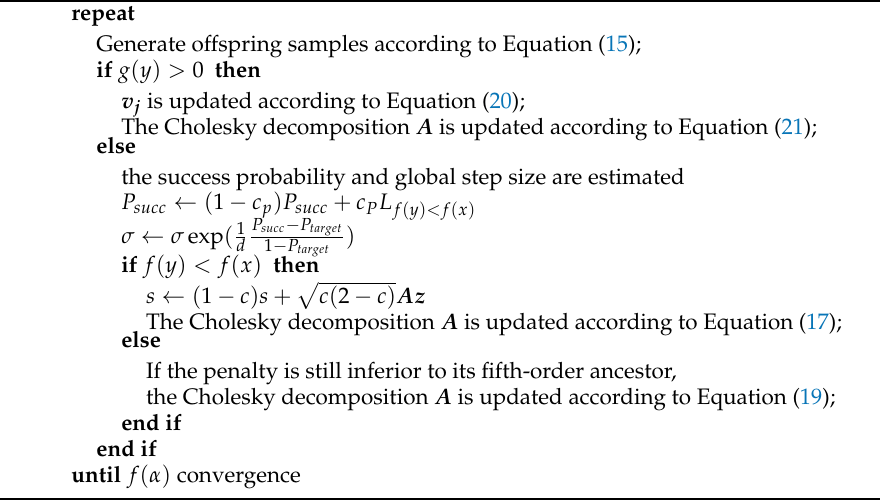
Figure 7. Evolved variance of the offspring distribution along the normal direction of the boundary. ( a ) Original distribution; ( b ) reduced distribution; ( c ) inverse Cholesky decomposition. Additionally, the parent is donated as red point, while the offspring distribution is given in green circle (ecllipse). The gradient direction is define with blue dashed line. Algorithm 3: Evolving learning of the sensitivity